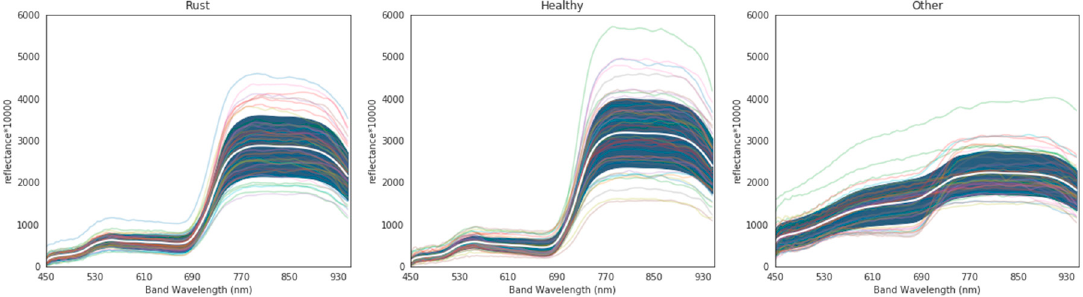
Figure 10. The spectrum profiles of randomly chosen 1000 pixels in rust, healthy and other (bare soil) regions of the images captured on the 18 May 2018. The white curve represents the mean value of all pixels.